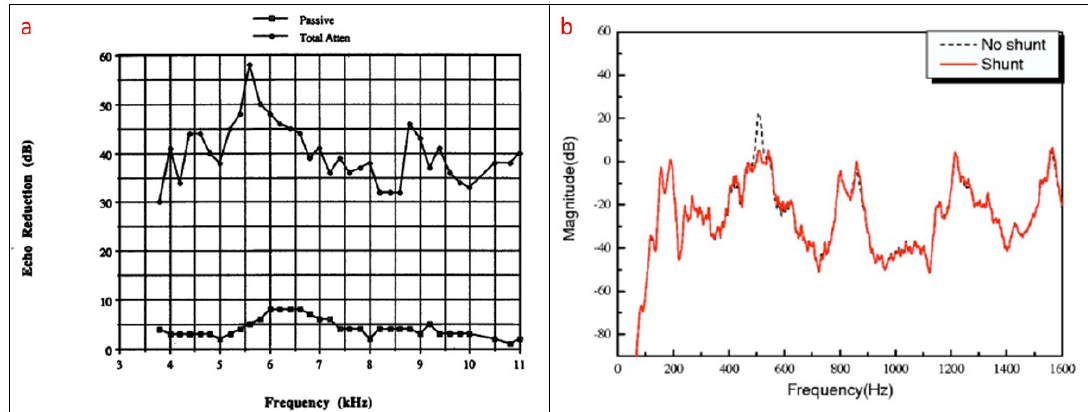
Figure 6. ( a ) Passive/active sound absorber in underwater. Reduction of noise for a broad bandwidth for passive mechanism and passive/active actuator [61]; ( b ) Reduction of noise for a particular mode with shunt method